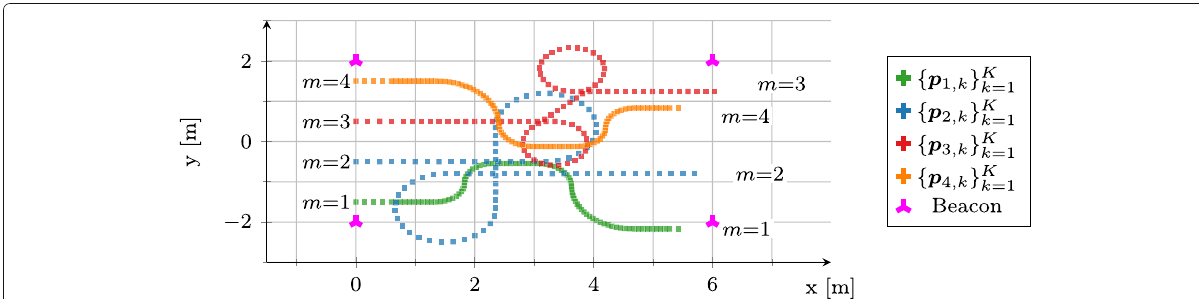
Fig. 2 Simulation setup with four agents and four beacons. The agents’ true trajectories are